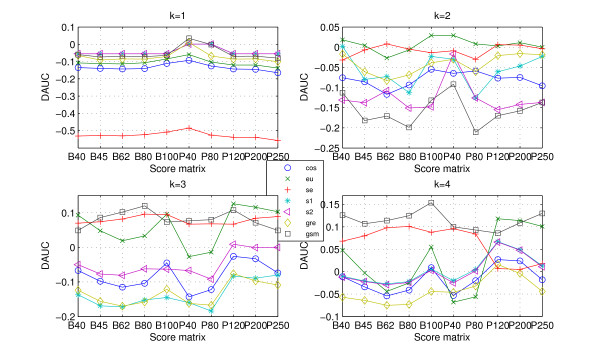
DAUC values for data CK. The DAUC values of seven statistical measures for data CK. All statistical measures based on k-word frequencies of protein 'sequence space' run with k from 1 to 4, where protein 'sequence space' is constructed according to ten score matrices. One graph presents each word length (from 1 to 4).